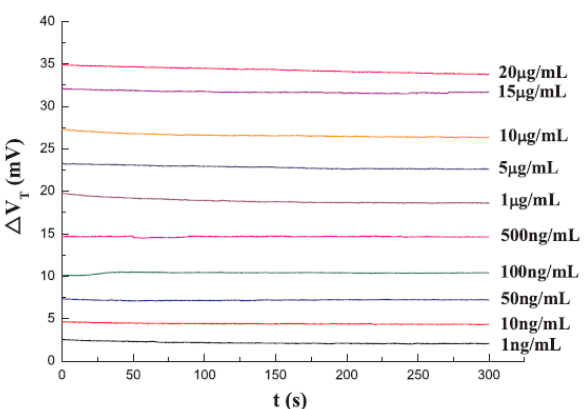
Figure 12. TMR biosensor signal response to the aggregated magnetic particles on T line with different concentrations of ricin [12]. Reprinted with permission from Elsevier 2019.